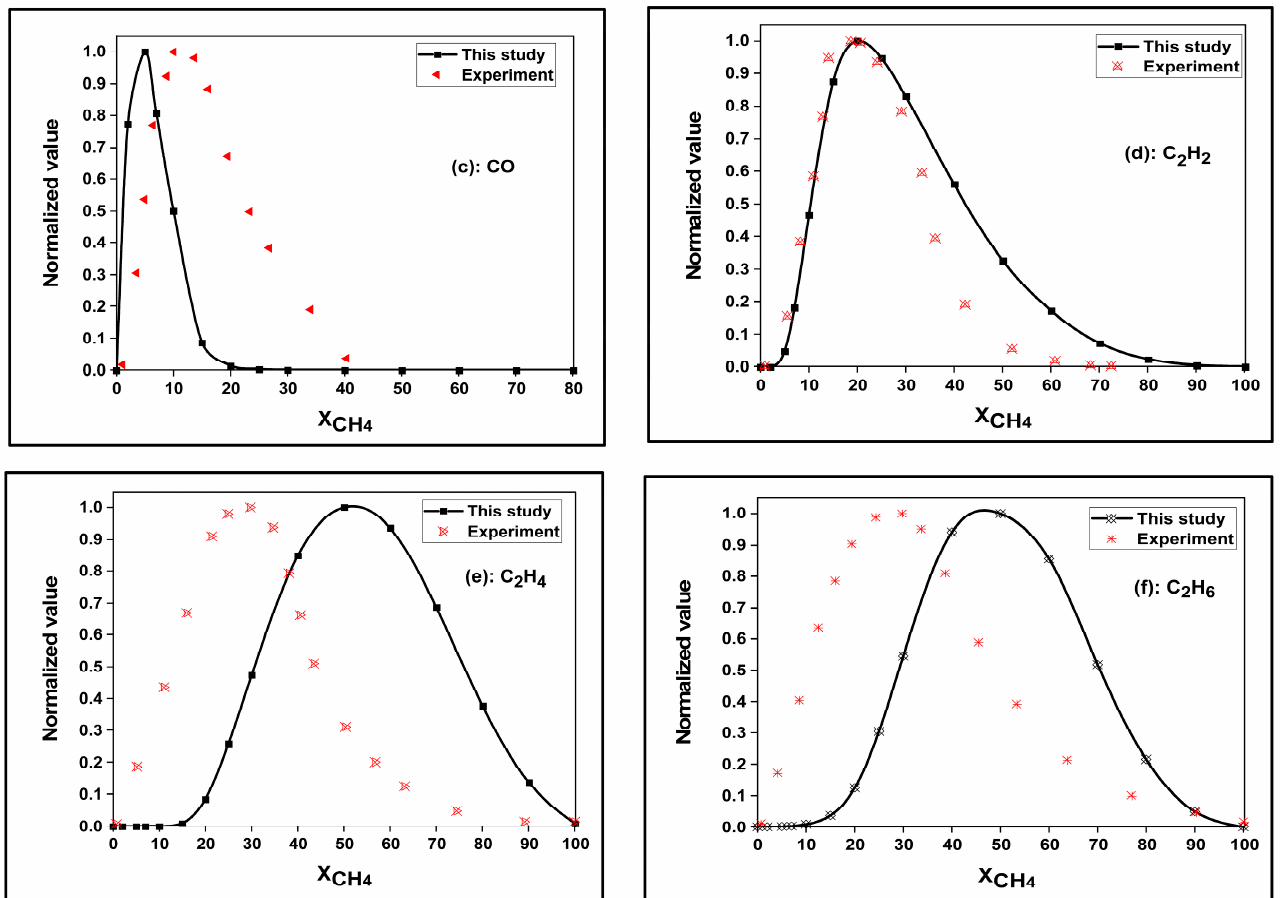
Figure 2. Comparison of our results (molar yield for a single bubble) with the experimental findings of Hart et al. (production rates) [21] for the sonochemical formation of H 2 , CO, C 2 H 2 , C 2 H 4 , and C 2 H 6 and the conversion of methane at f = 300 kHz and In = 2 W/cm² under Ar–CH 4 atmosphere (X CH4 =